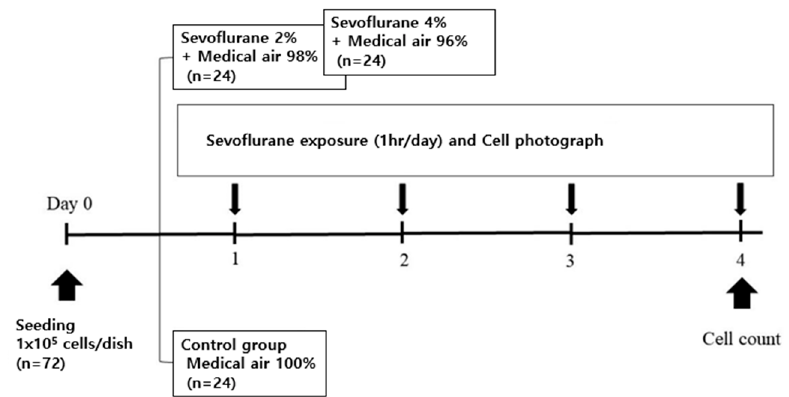
Figure 1. Schematic illustration for the in vitro study with oxygen.